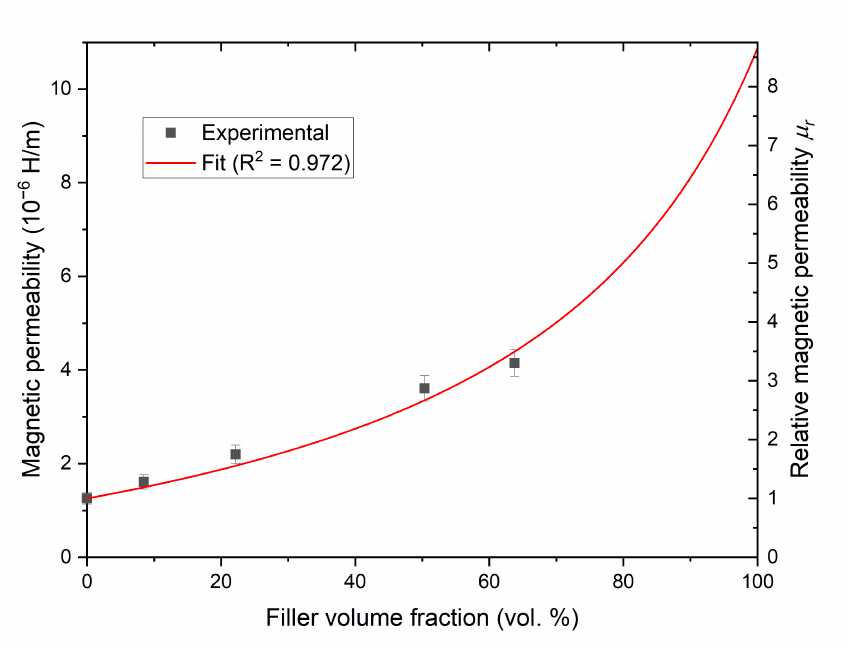
Figure 5. Evolution of the magnetic permeability as a function of the filler volume fraction. The red line is the fit of the experimental data using Equation